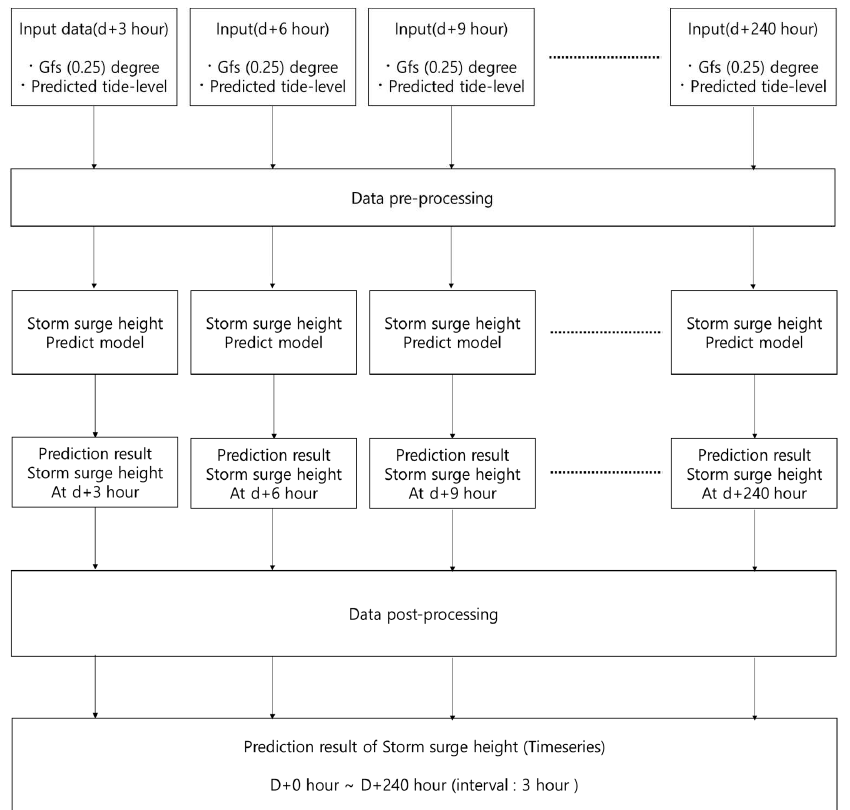
Figure 3. Process of storm surge forecasting. This process uses the GFS data and predicted tide level, which gives the harmonic tide level.